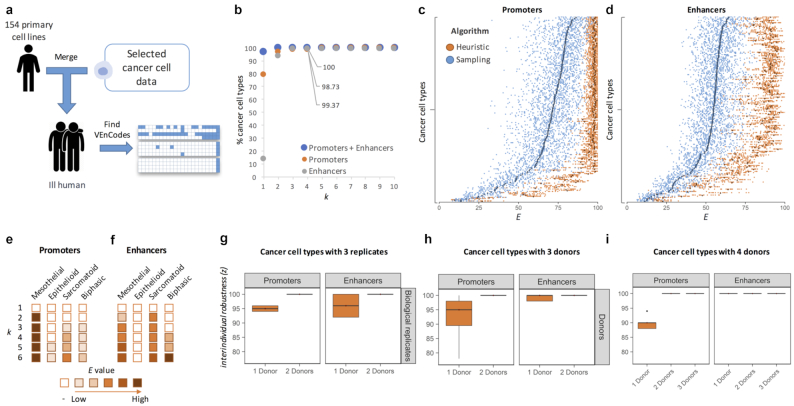
VEnCodes for cancer cell types. (a) Strategy for simulating a cancer patient in silico. (b) Probing the intersection genetics landscape for cancer cell types using the Heuristic2 method. Plotted are the percentages of cell types found to have at least 1 VEnCode per k using promoter (orange circles), enhancer (gray circles), or promoter + enhancer (blue circles) data. (c, d) The effect on E values of using sampling (blue) or heuristic (orange) methods to obtain VEnCodes for cancer cell types. The heuristic method increases the average E for most cell types for (c) promoter and (d) enhancer data. They axis represents different cancer cell types ordered by increasing theE obtained by the sampling method. Each dot is a VEnCode (n = 5–20 per primary cell type). Darker diamonds represent the mean. (e, f) Case study of mesothelioma cancer cells stratified into epithelioid, sarcomatoid, and biphasic subtypes. Primary mesothelial cells are shown in the left column for reference. Rows depict increasing k. Boxes are filled if at least 1 VEnCode is found using k REs. If a VEnCode is found, the box is colored according to the binned average E value of the VEnCodes found (n = 1–20). (g–i) Box plots representing interindividual robustness z values obtained from all cancer cell types with (g, h) 3 or (i) 4 donors based on promoter (left panels) and enhancer (right panels) data. (g) Subsets of cancer cells for which biological replicates were available (i.e., repeated assays with the same cancer cell line). (h, i) Subsets of cancer cell types for which independent cell lines were analyzed. z is saturated at 100% for all cell types tested when VEnCodes are determined using data from 2 cell donors.